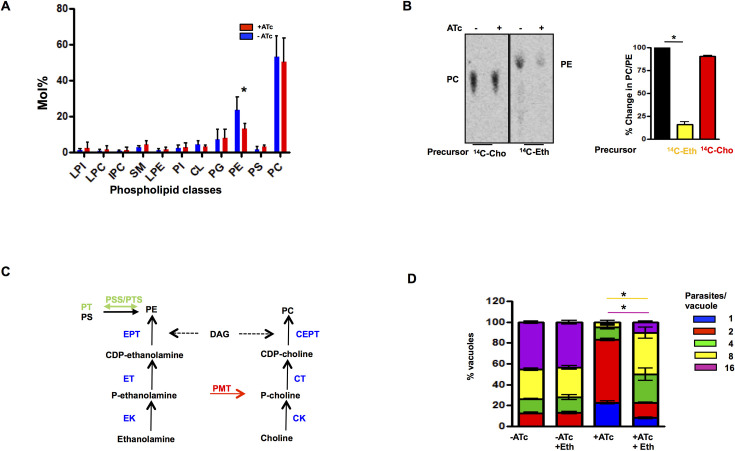
TgCDPK7 is involved in phospholipid metabolism.A. Total lipid isolated from TgCDPK7-iKD tachyzoites grown in the presence or absence of ATc and separated by HPTLC. After quantification by GC-MS and normalization with respect to cell number content relative to total fatty acids was determined. Phospholipid profiling showed the abundance of major phospholipid classes and points at the significant reduction of PE upon TgCDPK7 depletion (mean ± SE, *, n = 4, p<0.05, t-test). B. Metabolic labeling to monitor the synthesis of PC and PE. Extracellular TgCDPK7-iKD tachyzoites were incubated with 14C-Eth or 14C-Cho in the presence or absence of ATc. Subsequently, lipids were extracted and radiolabeled lipids were detected by phosphoimaging of TLC (Left panel). Right Panel, Radiolabeled spots corresponding to PE and PC (left panel) were quantitated by densitometry (right panel) and % change in PC and PE formation in ATc-treated parasites with respect to untreated parasites was calculated (mean ± SE, *n = 3, p<0.001, ANOVA). C. Metabolic pathways depicting the synthesis of PC and PE in P. falciparum and T. gondii. The enzymes conserved in two parasites are indicated in black. PMT is solely encoded by P. falciparum, is indicated in red and PTS/PSS involved in conversion of PE to PT or PS in T. gondii is shown in green [29]. D. TgCDPK7-iKD parasites were pre-incubated for 48h with ATc and were subsequently allowed to invade fresh HFFs in the presence or absence of ATc. In one case, 200 μM Eth was added to cultures prior to the addition of ATc. The number of parasites per vacuole was determined after 24h. Data represent mean ± SE, n = 3 and at least 200 vacuoles were counted for each condition (ANOVA, *, p<0.001 for 8/16 parasites/vacuole).